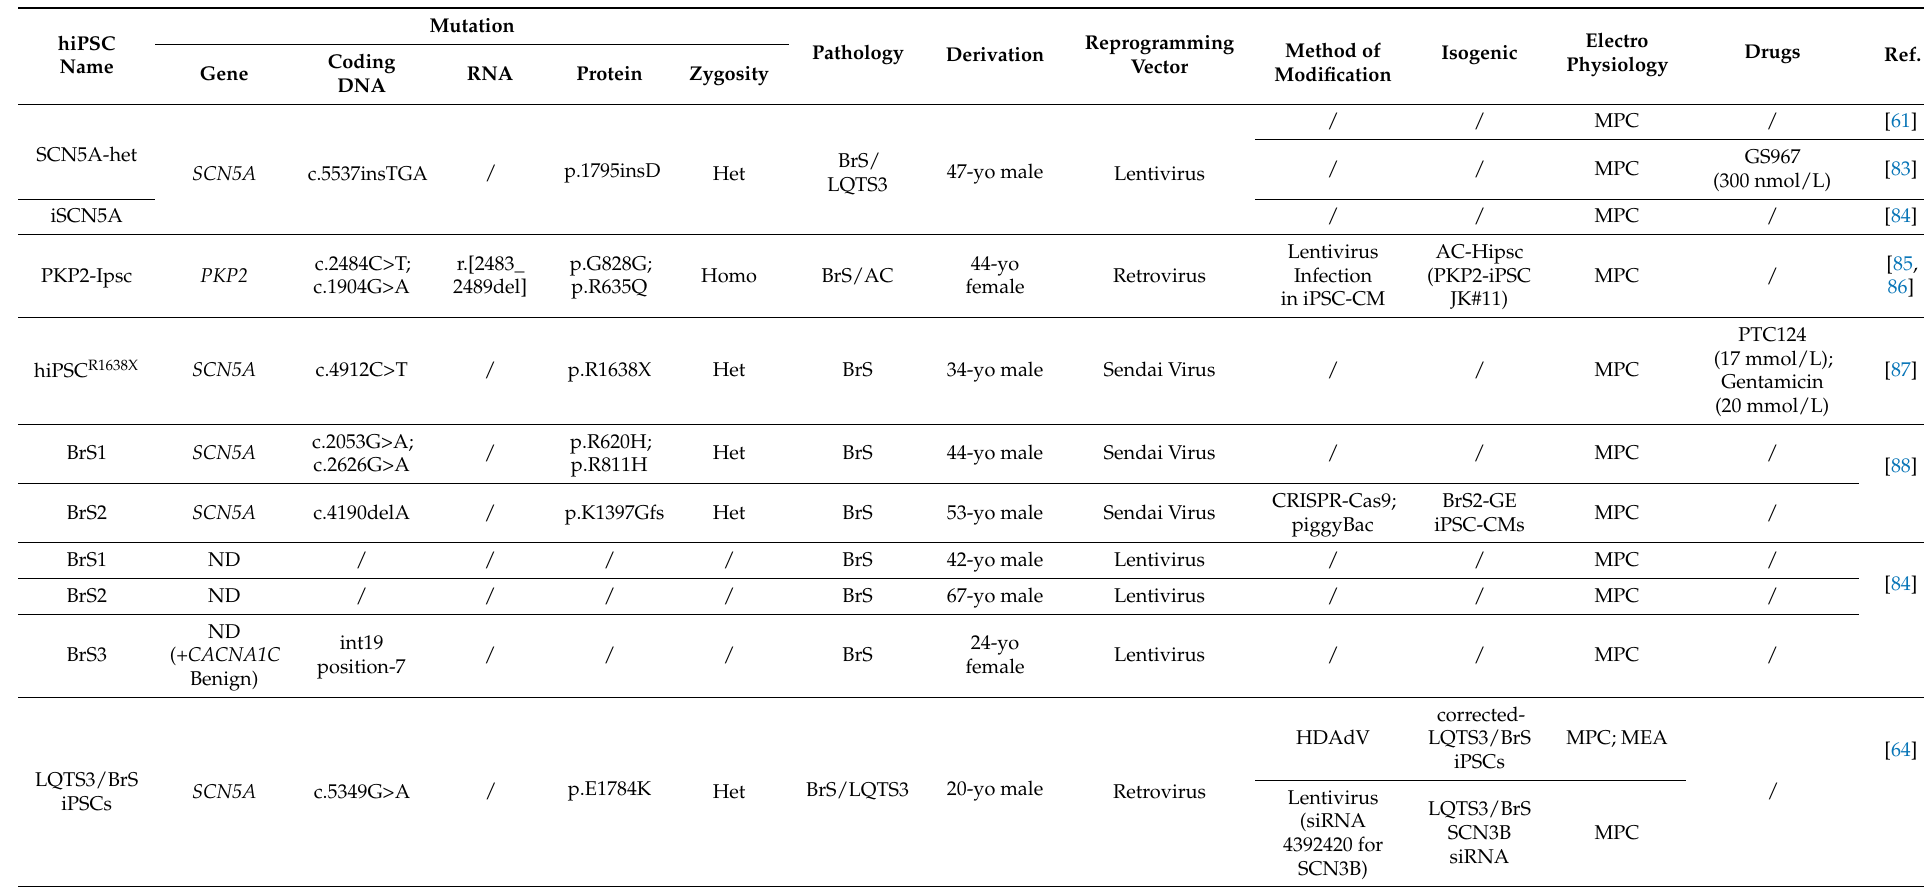
Table 2. BrS-related hiPS-CMs models. (ND = not defined; AC = arrhythmogenic cardiomyopathy; ERS = early repolarisation syndrome; JWS = J-wave syndrome; het = heterozygous; homo = homozygous; HOS = holt-oram syndrome; / = not